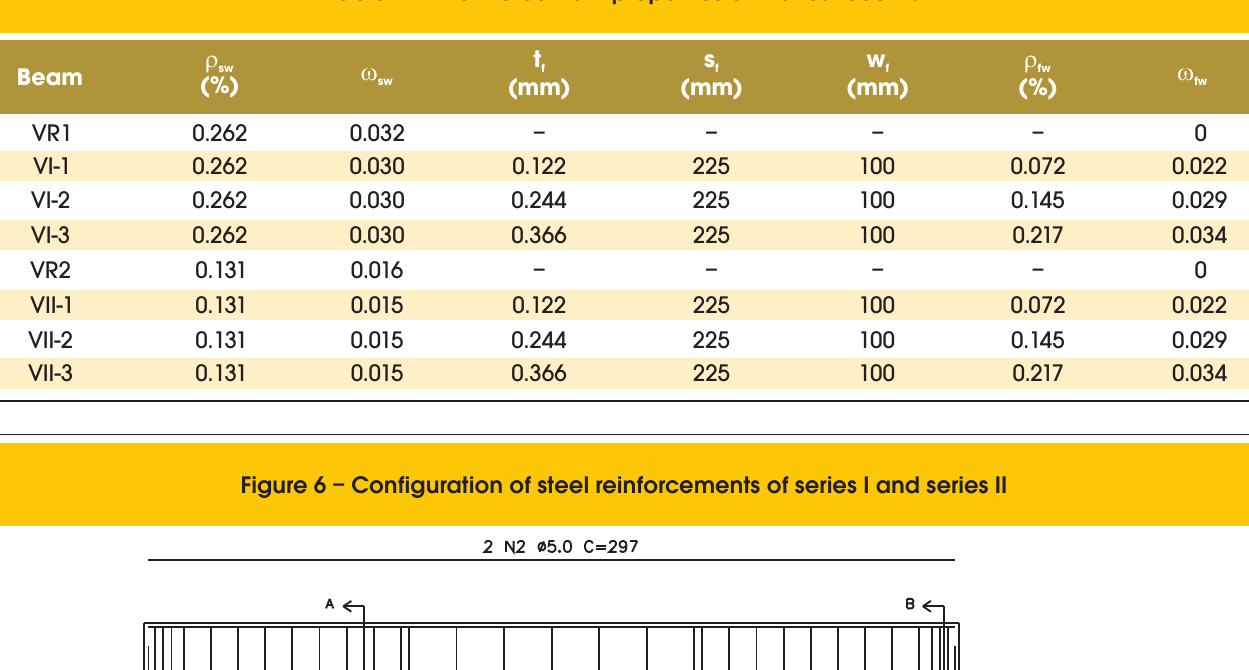
Table 1 – Reinforcement properties of the test beams